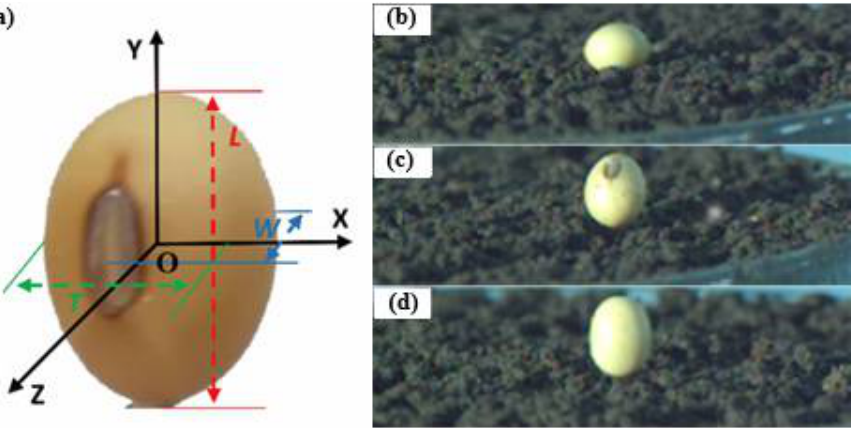
Figure 13. ( a ) Tri-axial dimensions of an actual soybean seed particle [16], soybean seed particles collide with soil in different orientations of ( b ) horizontal, ( c ) lateral and ( d ) vertical. Figure 14 is the relationship between bounce distance and impact orientation for the three varieties. The analysis showed that the bouncing distance of the soybean seed different orientations, but the bouncing distance as a whole was not very high. ZD39 had